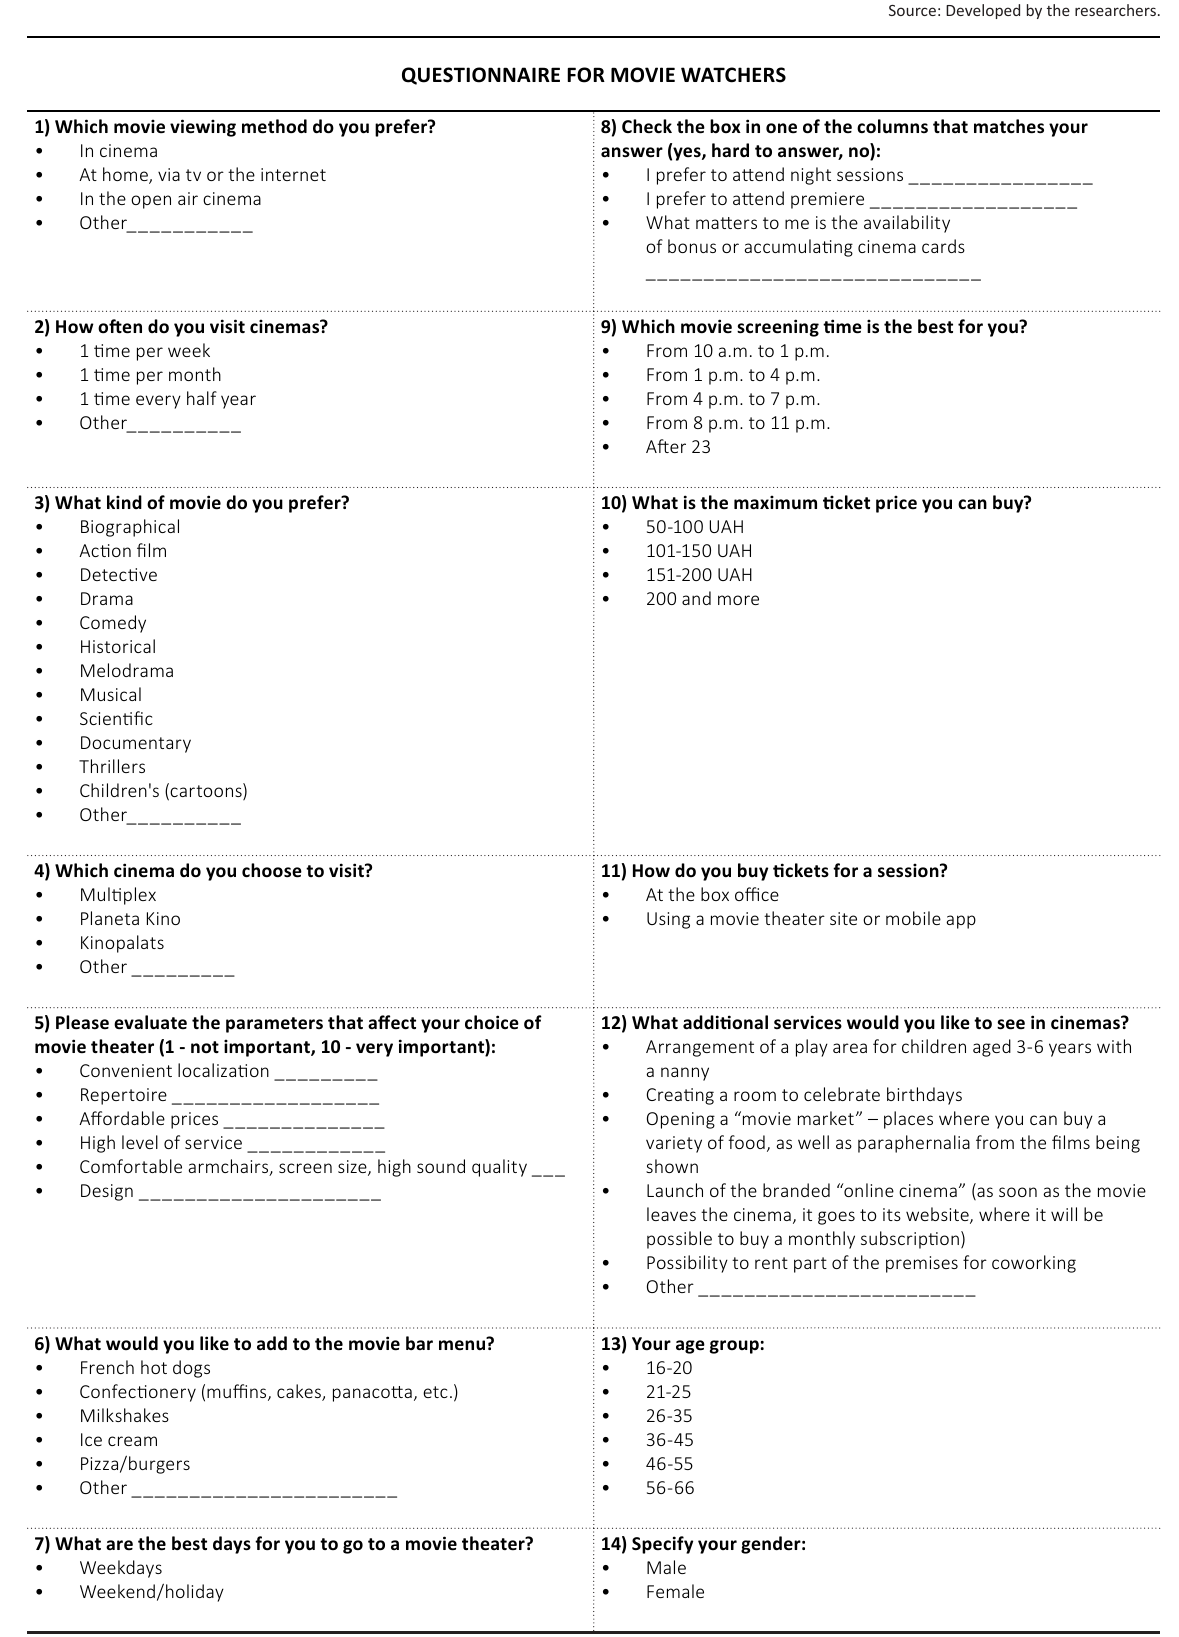
Figure 4. Questionnaire for movie